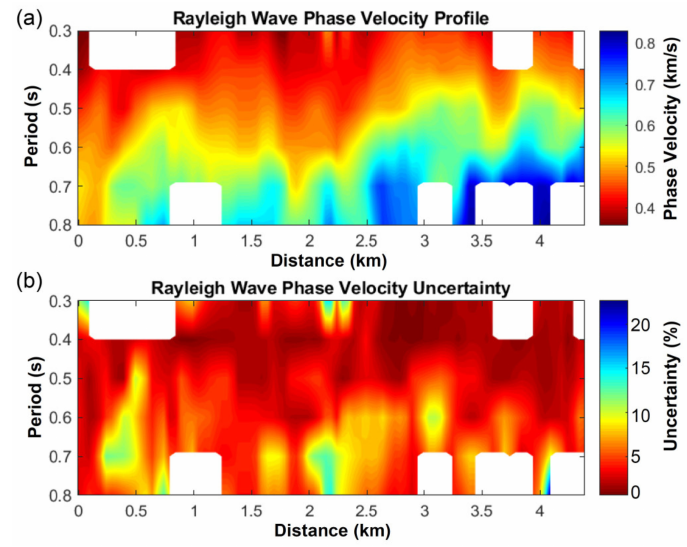
Figure 6. ( a ) The Rayleigh wave phase velocity profile and ( b ) its uncertainty profile as measured by the double beamforming method.